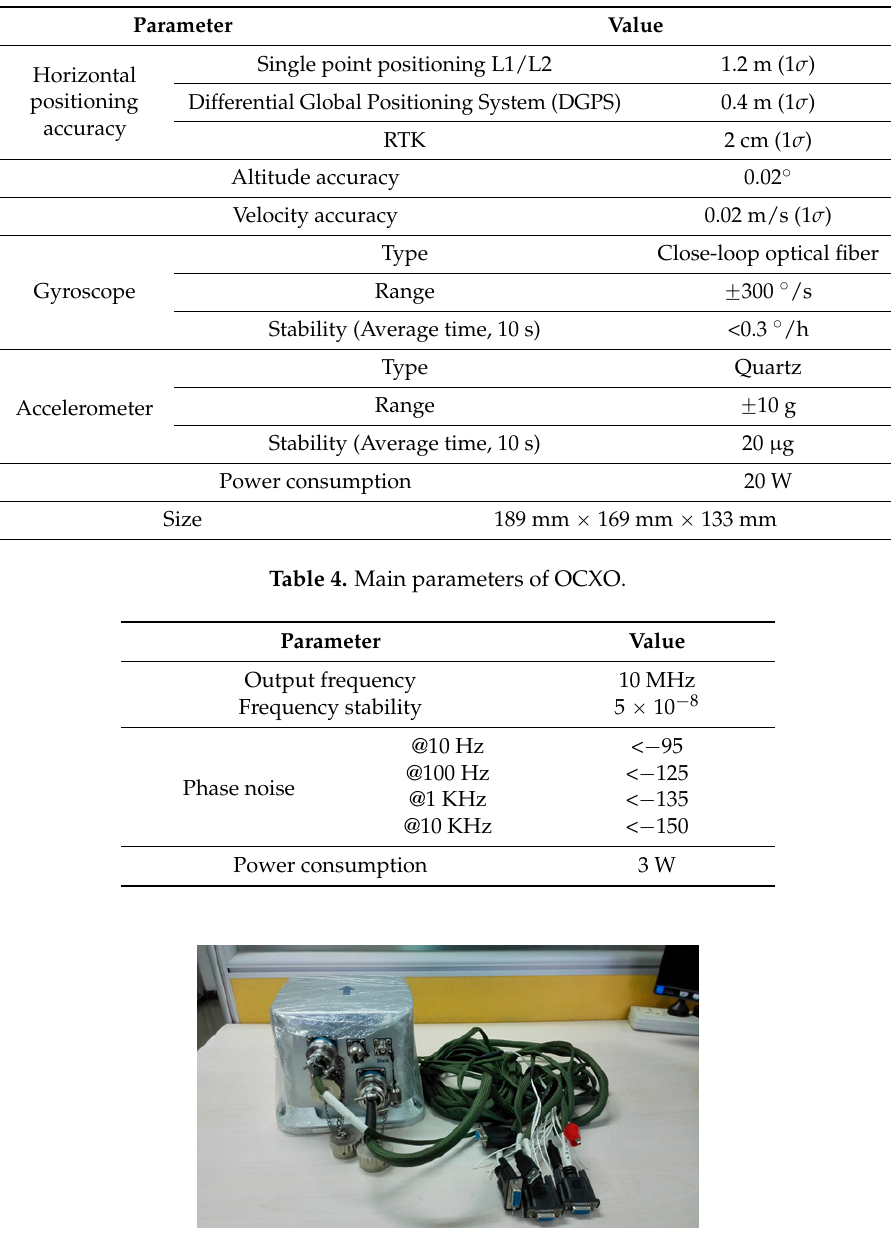
Table 4. Main parameters of OCXO.